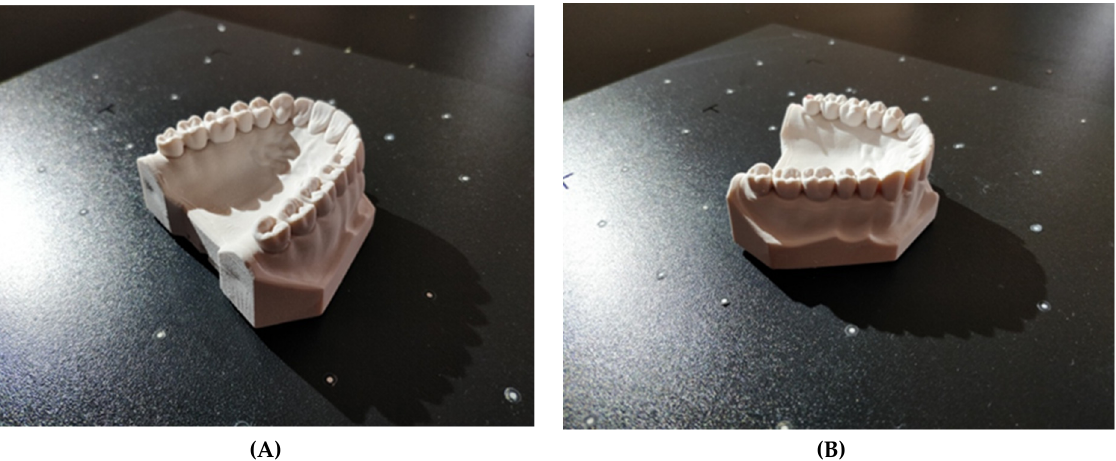
Figure 3. ( A ) Model manufactured through SLA; ( B ) Model manufactured through DLP.